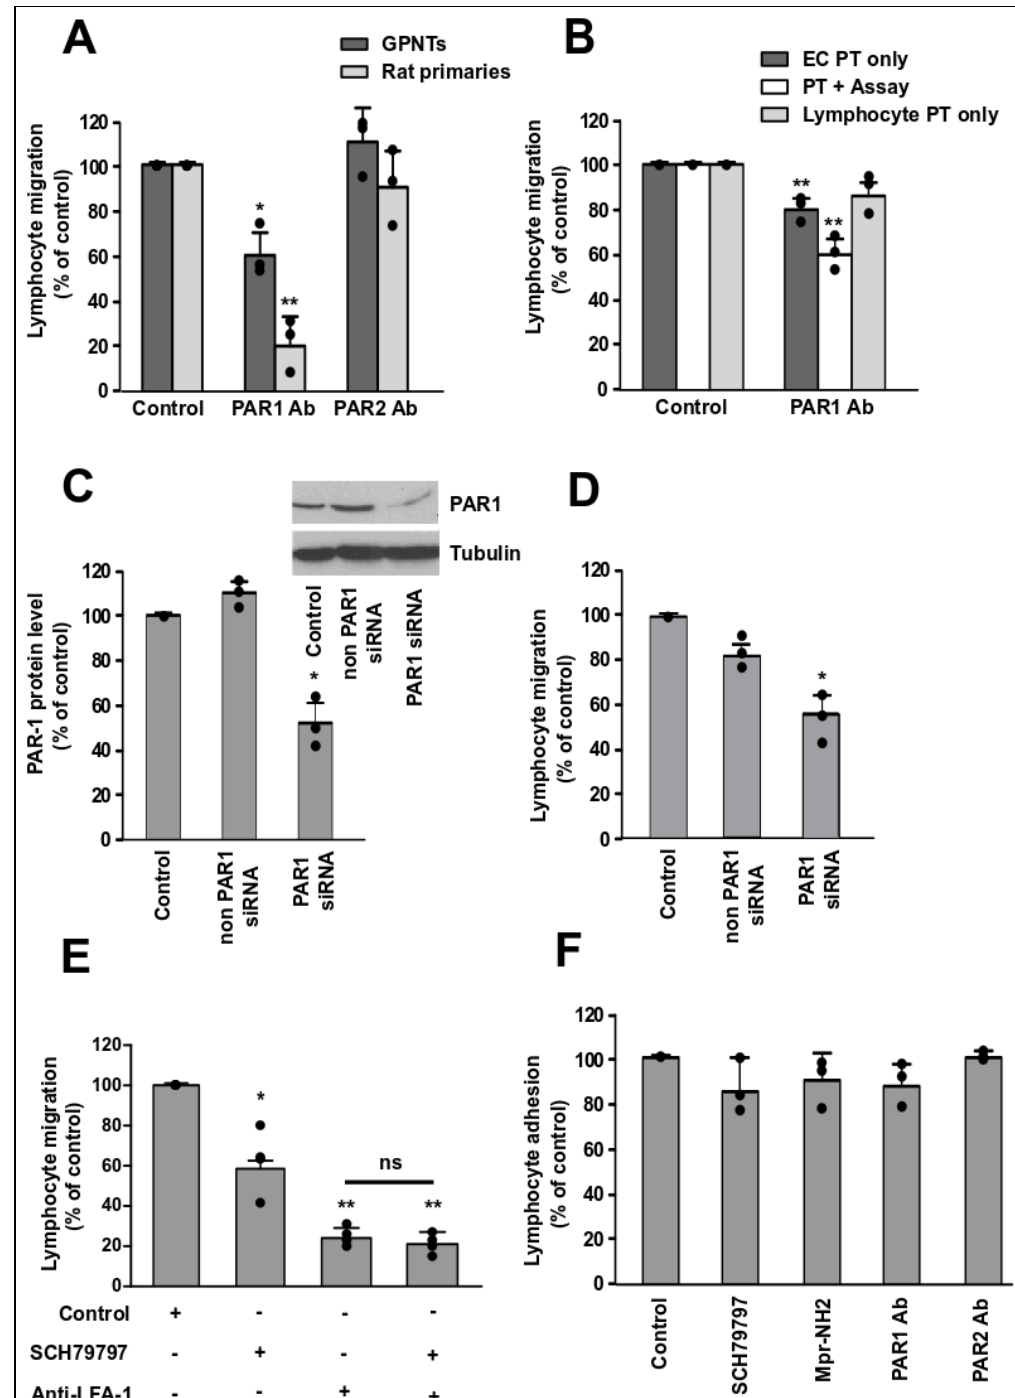
Figure 2. Endothelial PAR1 is required for TEM. ( A ) GPNT or primary rat BMVEC were pre-treated for 1 h and maintained during the TEM assay with PAR blocking antibodies (ATAP-2, 10 µg/mL for PAR1; SAM-11, 30 µg/mL for PAR2). PAS lymphocyte migration was then measured after 4 h. ( B ) TEM rates were assessed after 30 min to eliminate effects due to altered gene expression. GPNT were either pre-treated (EC PT) or pre-treated and maintained (PT + assay) with the PAR1 blocking antibody ATAP-2 (10 µg/mL). Alternatively, only PAS were pre-treated (Lymphocyte PT). ( C ) GPNTs were transfected with siRNA non-targeting or targeting PAR1 (200 nM) and PAR1 levels were assessed in relation to cellular tubulin by western blot (representative example shown in the inset).